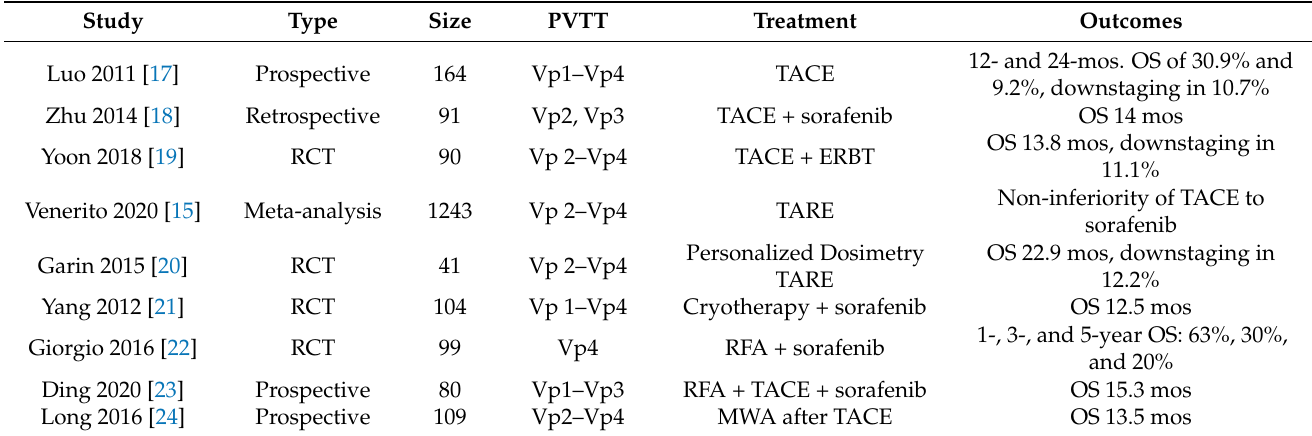
Table 1. Locoregional therapies for HCC with